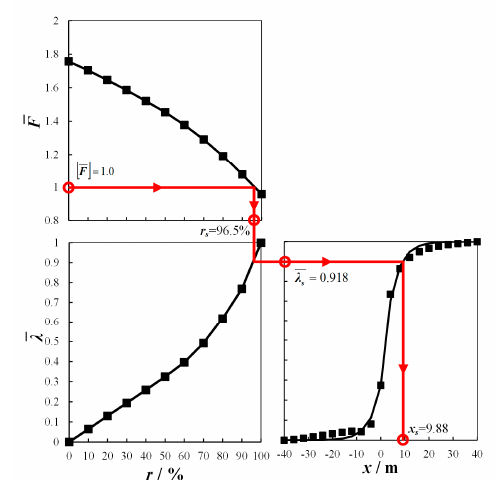
Figure 11. Installation location of initial ground support.